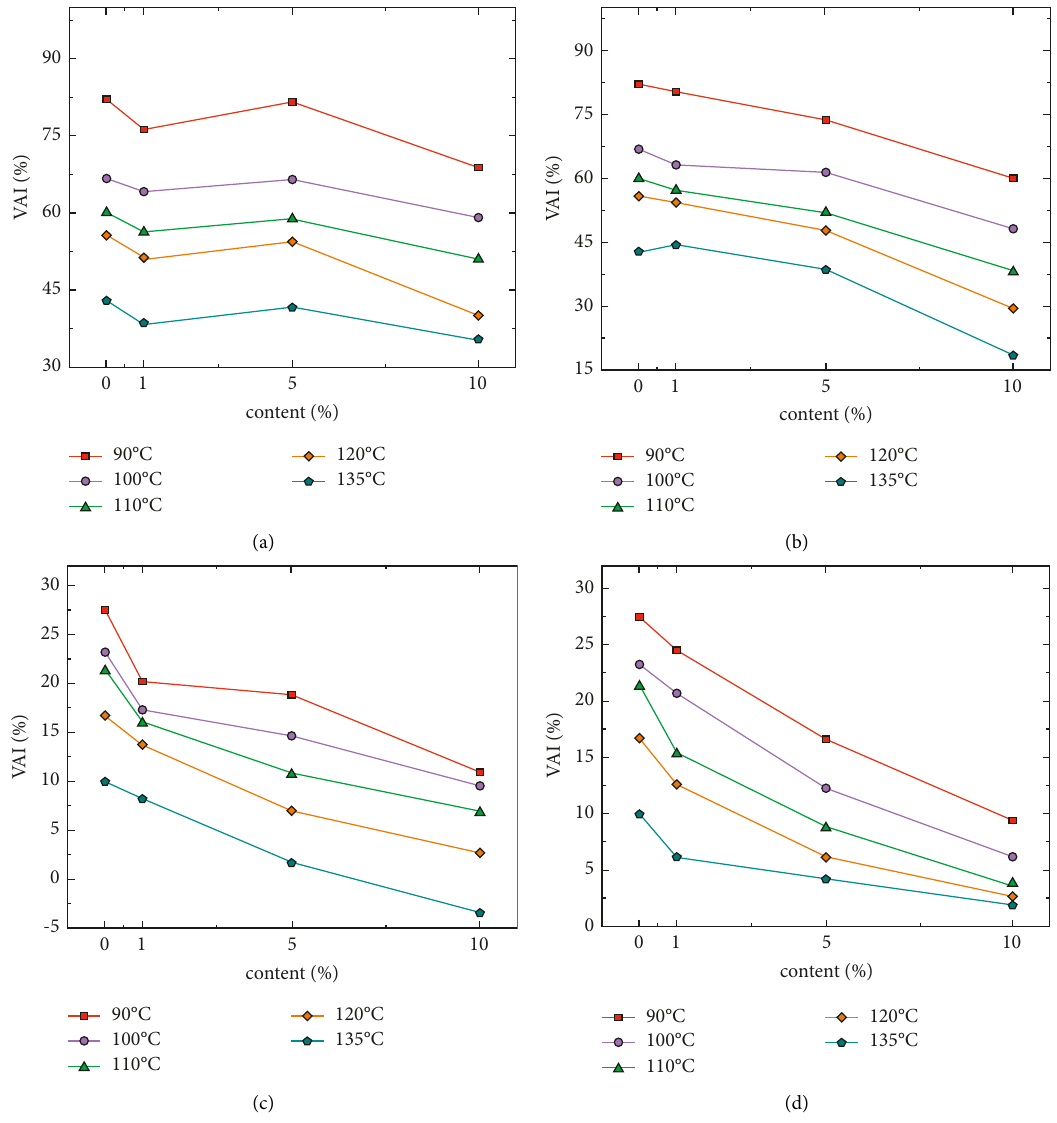
Figure 7: Viscosity aging index of different